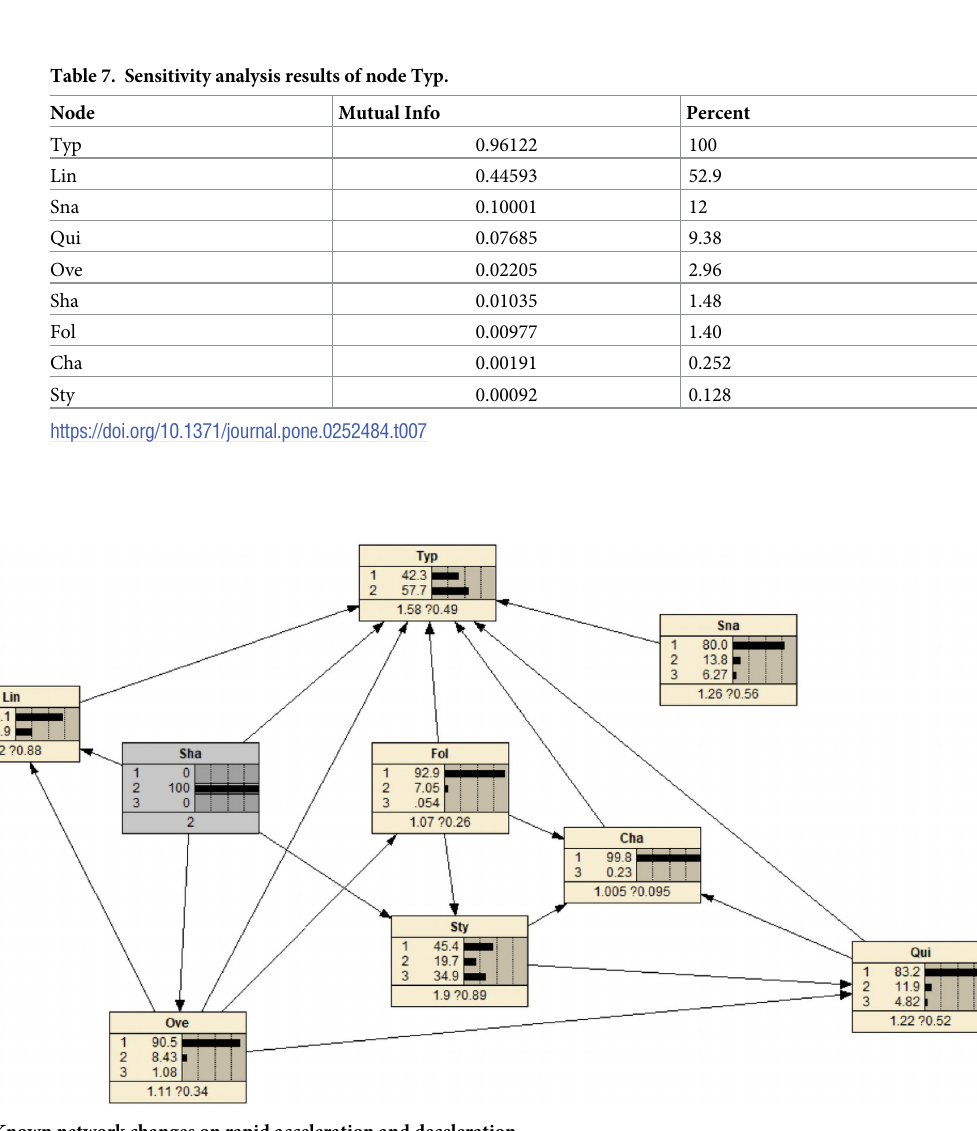
Fig 9. Known network changes on rapid acceleration and